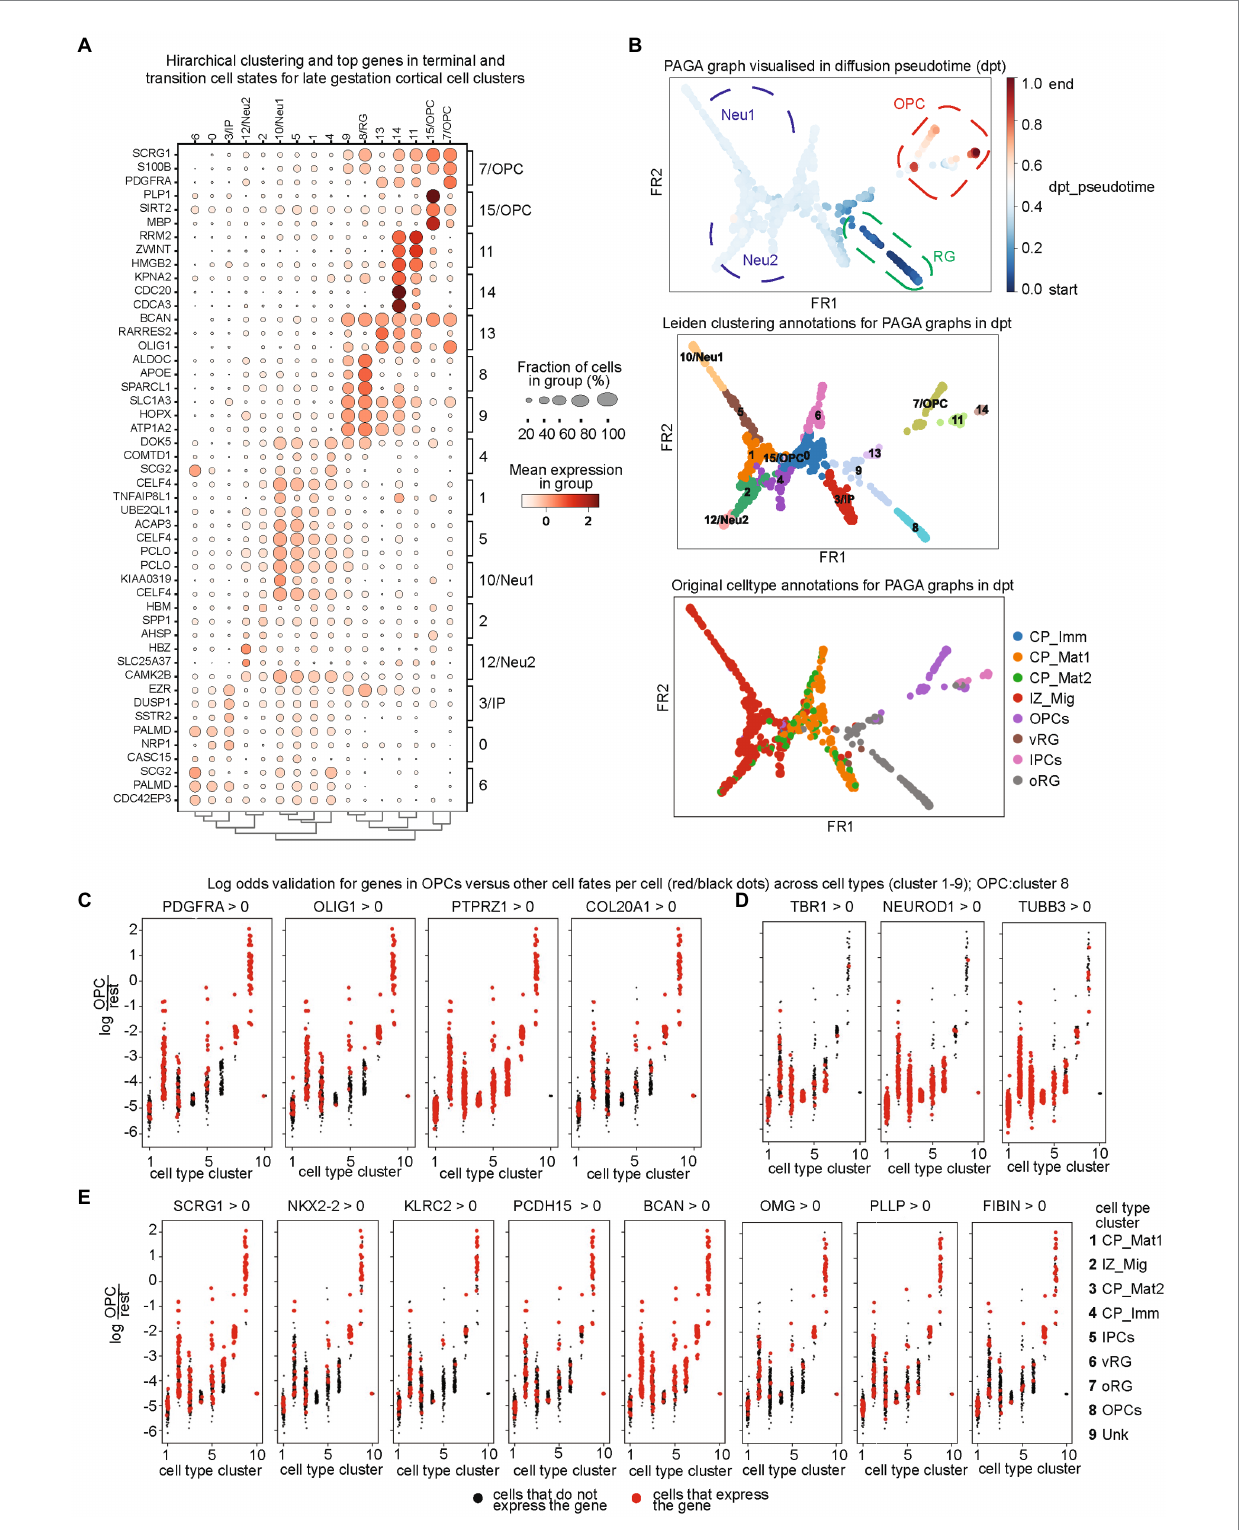
FIGURE 2 (A) Cellular state-specific top gene sets at late gestation time: Hierarchical clustering of identified PAGA clusters and their top genes in terminal and transition cell states for late gestation cortical cells. Fraction of cell numbers is represented in percentage (%), indicated by the circle size and mean expression intensity from low (white color) to high (red); (B) Diffusion pseudotime (dpt_pseudotime) plot for PAGA clusters (upper panel), which is then annotated into the PAGA cluster annotations (middle) and then the original cluster annotations from the initial dataset (bottom panel). All annotations show great alignment and confirm the accuracy of diffusion pseudotime. The dpt_pseudotime panel shows the radial glia lineage in dark blue, then neuronal in light blue, and later OPC lineage in red; (C–E) Validation of top lineage drivers by plotting the distribution of log odds for OPCs versus other cell fates per cell across cell types. Log-odds ratio confirmed the lineage specificity by comparison of OPC markers genes (C) , neuronal genes (D) , and the pre-OPC lineage